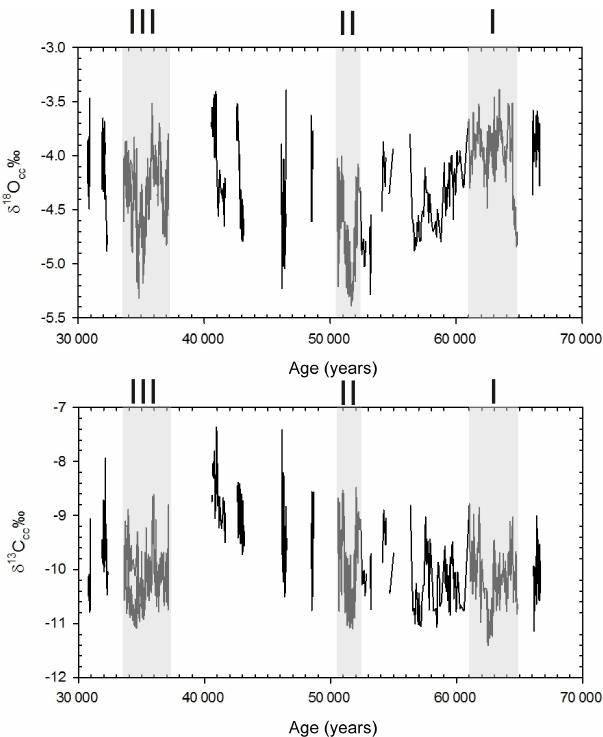
Figure 8. Carbon isotope ( δ 13 C cc ) record for SC-06-01 compared to oxygen isotope record ( δ 18 O cc ; Hoffmann et al., 2016). Growth Phases I, II and III are shown as grey